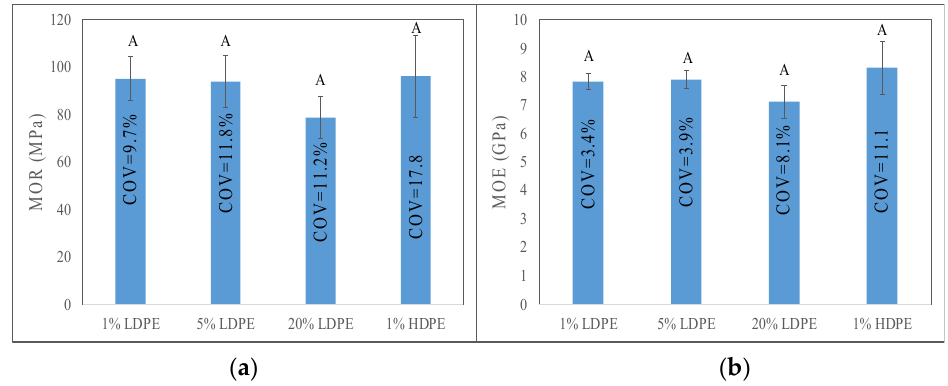
Figure 7. ( a ) Modulus of rupture (MOR) or the bending strength and ( b ) modulus of elasticity (MOE) or the bending stiffness results of RTM panels (PE types with the same letter above the bar indicate that their means were not statistically significant).